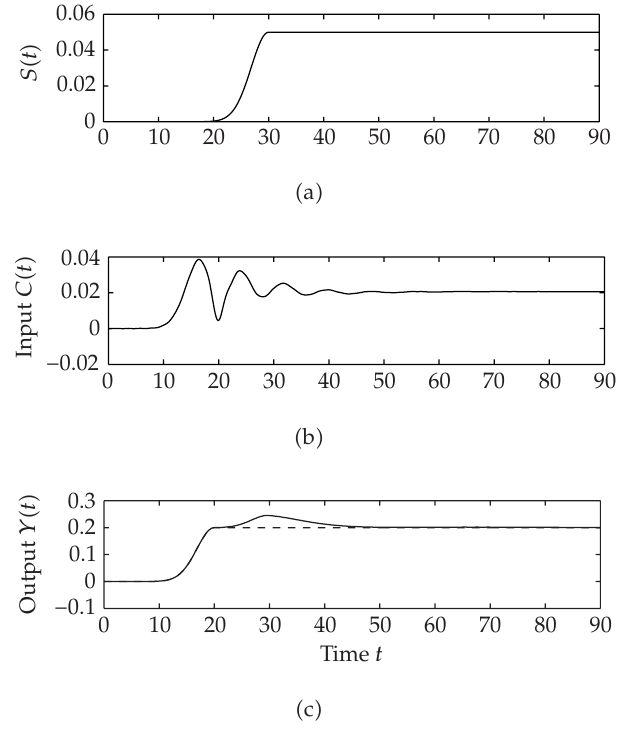
Figure 5.1 Closed loop simulation: ( a ) the input substrate concentration S , ( b ) the feedback control C , and ( c ) the reference output Y ∗ ( dotted ) and the resulting output Y ( solid )